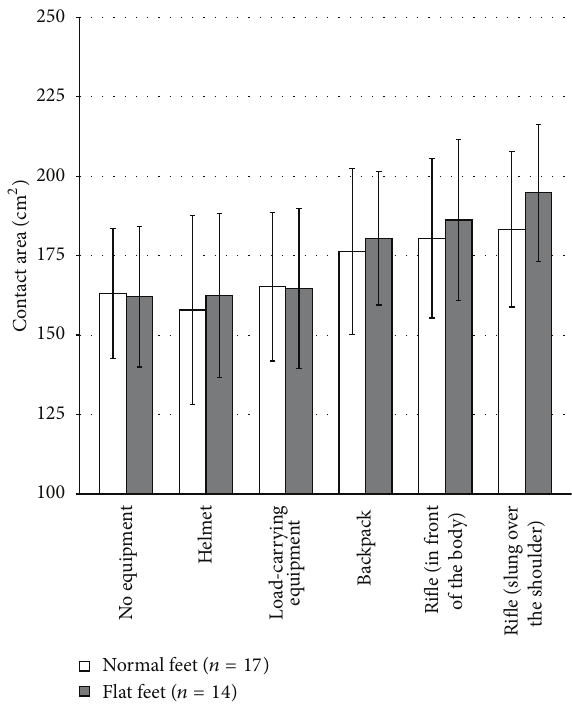
Figure 2: Contact area of both feet in cm 2 . Comparison of subjects with flat feet and subjects with normal feet as detected under static